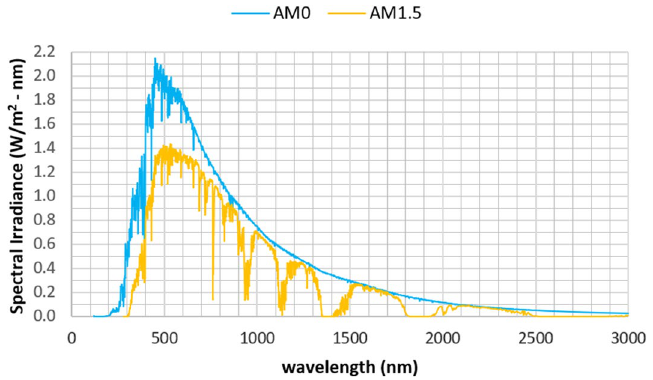
Figure 1. Solar radiation spectrum (Adapted from 19